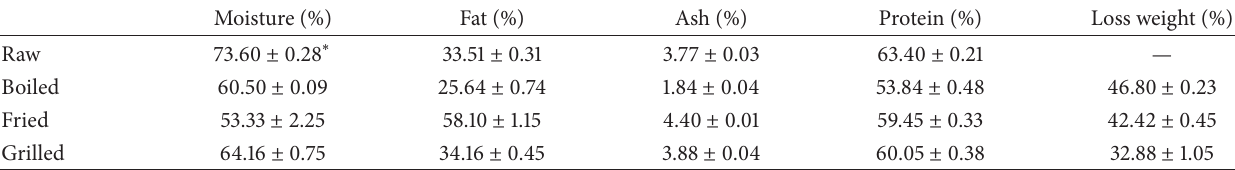
Table 1: Proximate composition of raw and cooked lamb (dry weight